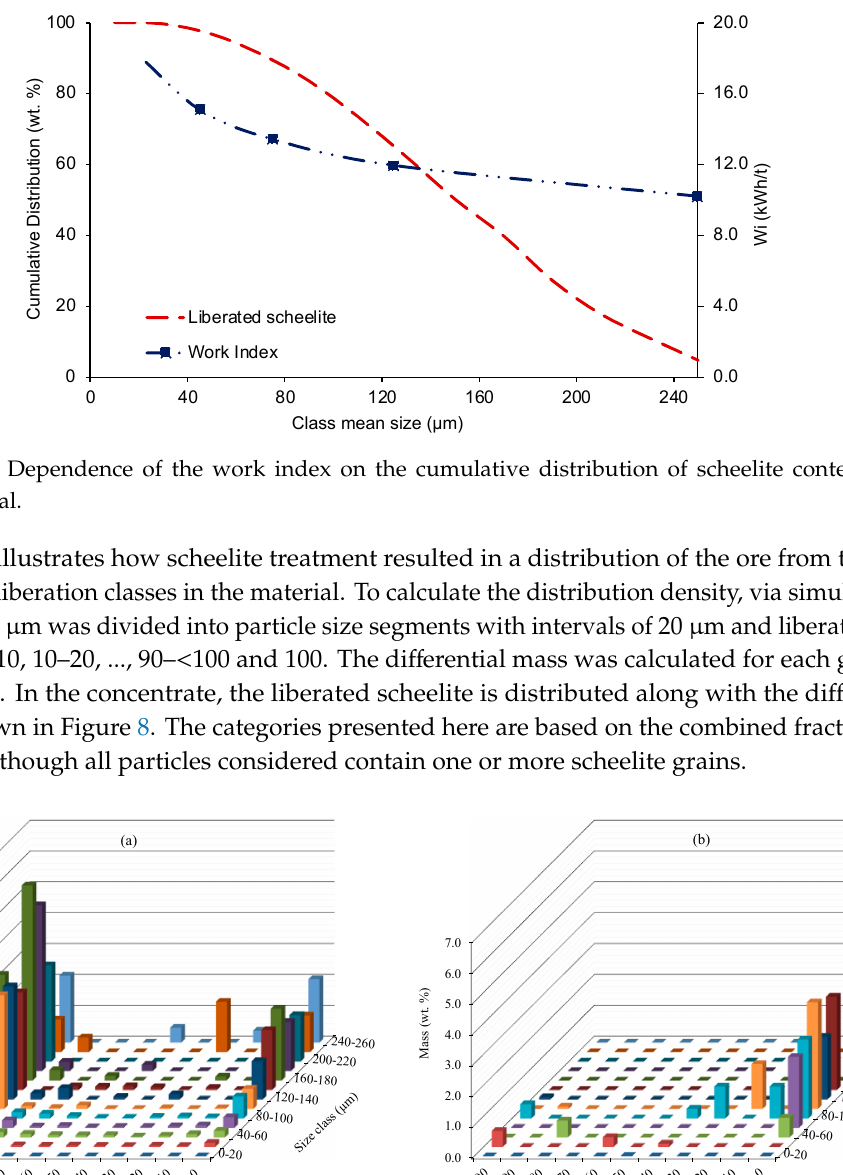
of them can be considered as